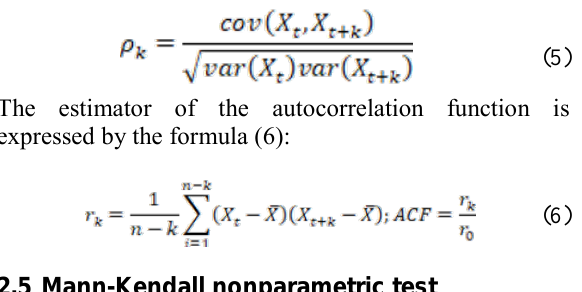
Fig. 2. Markham’s seasonality coefficients construction procedure. Explanations: r XI , r XII , ..., r X - vectors corresponding to the sums of flood volumes in a given hydrological month; R S - accidental vector for monthly vectors; α XI - the inclination angle of the given month (e.g. November) from the beginning of the hydrological year; ω - angle of incident vector (R S )